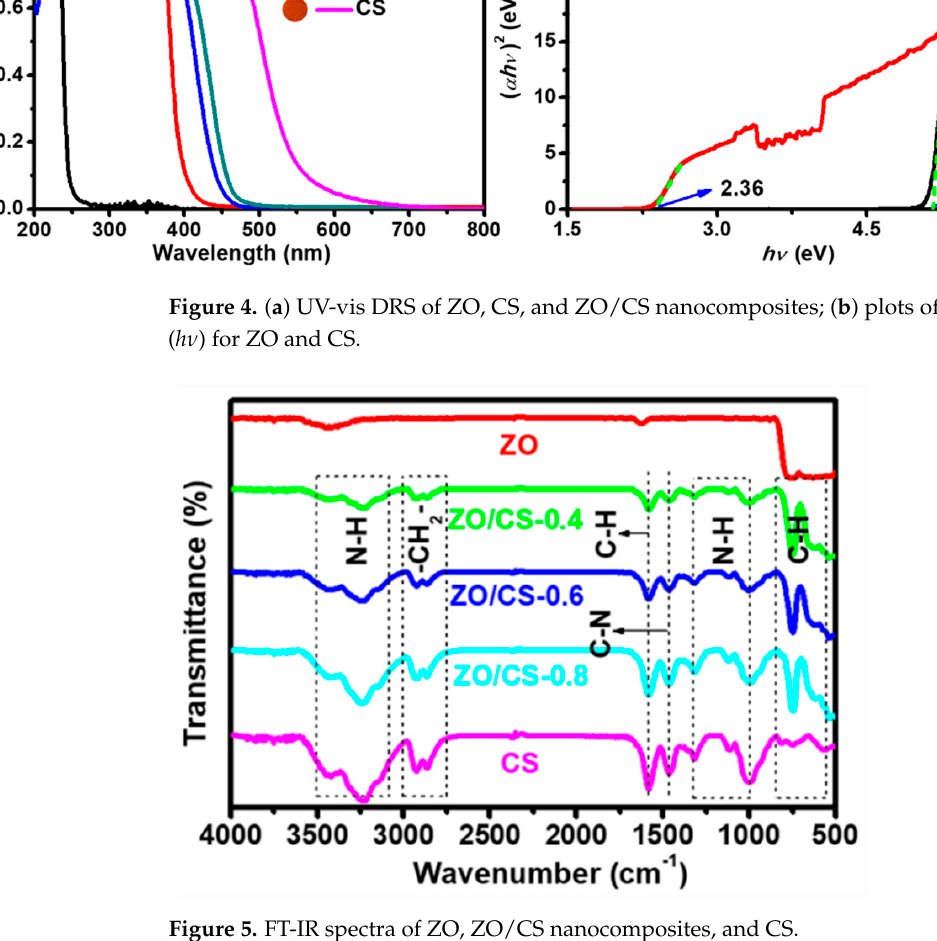
Figure 5. FT − IR spectra of ZO, ZO/CS nanocomposites, and CS. Figure 5. FT-IR spectra of ZO, ZO/CS nanocomposites, and